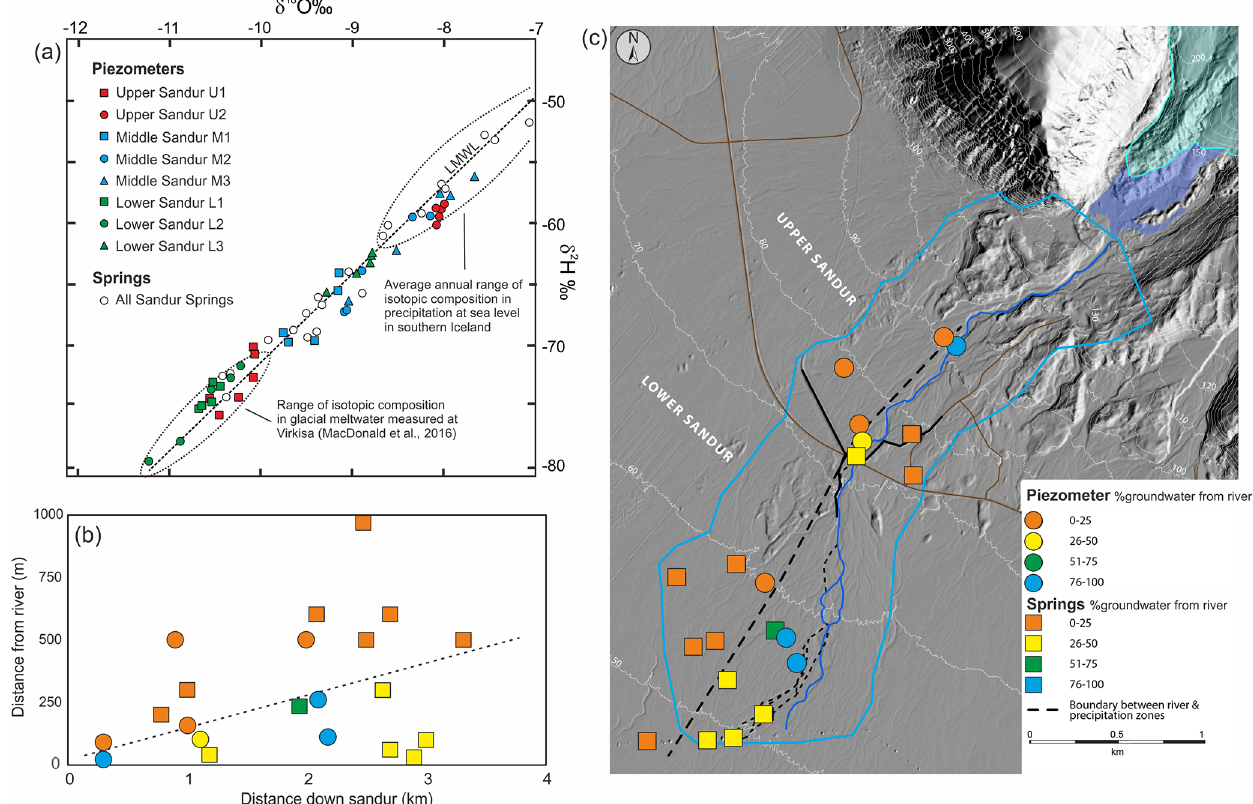
Figure 4. Stable isotope composition of waters and results of the binary mixing model of δ 2 H in groundwater. (a) Stable isotope composition of sandur groundwater in piezometers and springs. Individual piezometers labelled; piezometer locations in Fig. 1. Also shown are ranges in stable isotope composition of precipitation and river water (MacDonald et al., 2016). Plotted on the Local Meteoric Water Line (LMWL) calculated for Reykjavik. (b) Plot of the mean proportion of groundwater recharged from the river using binary mixing of the model of δ 2 H by perpendicular distance from the river and down-sandur. (c) Map of the mean proportion of groundwater estimated to be recharged from the river using a binary mixing model for δ 2 H. Hillshade model generated from LiDAR DEM © Veðurstofa Íslands,